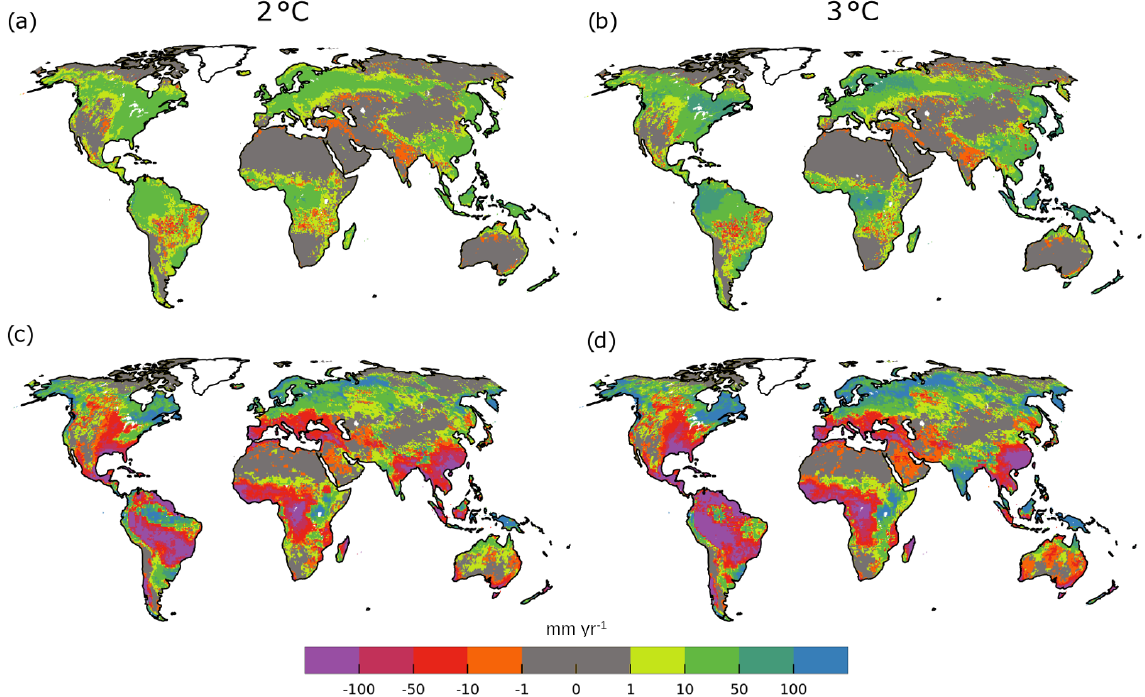
Figure 6. GWR (dynamic CO 2 ) compared to GWR (static CO 2 ; mmyr − 1 ) for 2.0 ◦ C (a) and 3.0 ◦ C (b) GW. GWR (dynamic CO 2 ) compared to PI (dynamic CO 2 ; mmyr − 1 ) for 2.0 ◦ C (c) and 3.0 ◦ C (d) GW. The figure only includes the GHM CLM 4.5 and the GCM GFDL- ESM2M. Maps show changes in GWR at a certain GW (including all RCPs that lead to that GW with a certain CO 2 concentration), with dynamically evolving CO 2 compared to static CO 2 concentrations from 2005. Green and blue mean that GWR is higher when evolving CO 2 concentrations are considered; red and purple indicate lower